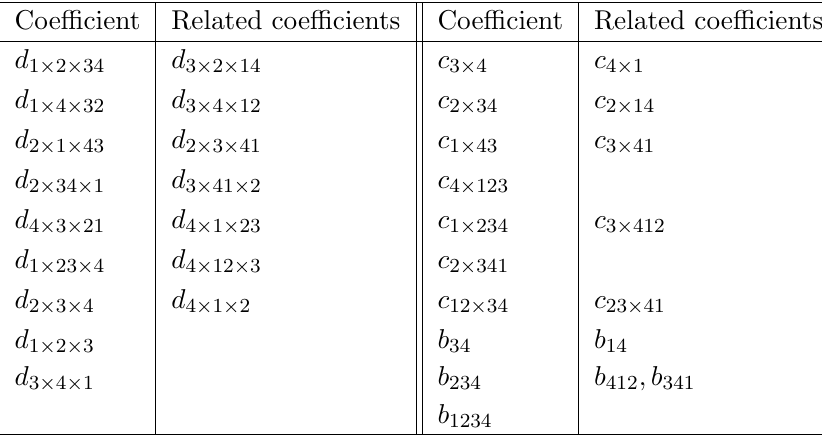
Table 2 . Minimal set of integral coe(cid:14)cients for 1 +